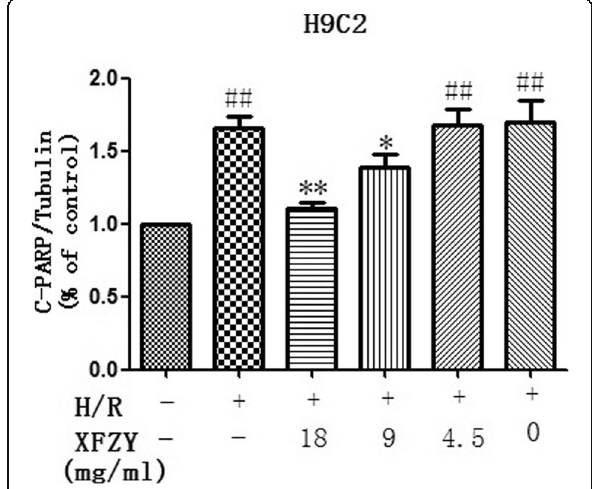
Fig. 4 XFZY inhibited apoptosis of H9C2 cells subjected to H/R. H9C2 cells were treated with XFZY under H10/R2, and the changes in RAPA expression were examined by western blot. The data were represented as mean ± SD of three independent experiments. Tubulin protein was used as a loading control. *p < 0.05, **p < 0.01 vs H/R group; ## p < 0.01 vs Vehicle group